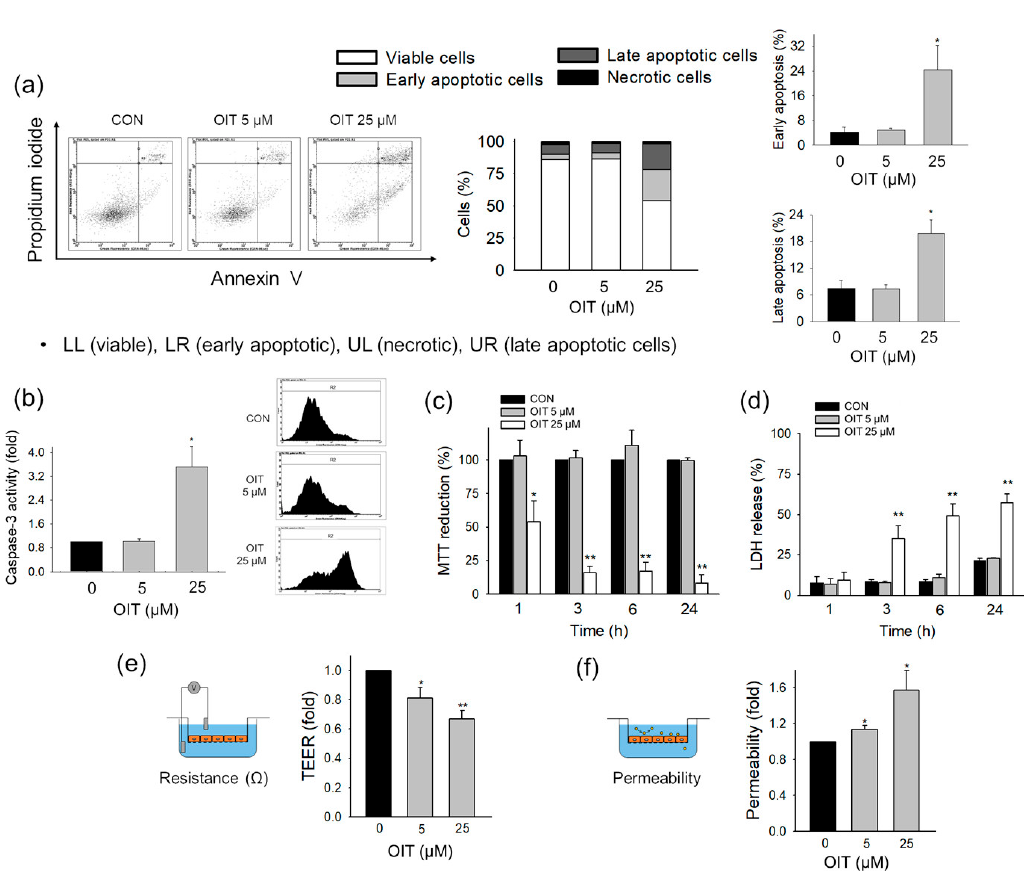
Figure 1. Effects of 2-n-Octyl-4-isothiazolin-3-one (OIT) on the apoptosis pathway, metabolic capacity, plasma membrane damage, and endothelial function in bEnd.3 cells. ( a ) Early-apoptotic, late-apoptotic, and necrotic cells were analyzed at 24 h after treatment with 0, 5, or 25 µ M OIT ( n = 4). ( b ) Caspase-3 activity was examined at 3 h after treatment with 0, 5, or 25 µ M OIT ( n = 4). ( c , d ) The extents of ( c ) MTT reduction and ( d ) LDH release were examined at 0, 1, 3, 6, and 24 h after treatment with 0, 5, or 25 µ M OIT ( n = 3–6). ( e , f ) Functional changes in endothelial permeability were analyzed by TEER measurements ( e ) and an in vitro FITC-dextran (m.w. 4000 Da) permeability assay ( f ) at 24 h after treatment of OIT ( n = 3–4). Data are presented as mean ± SEM. * p < 0.05, ** p < 0.01 vs. CON